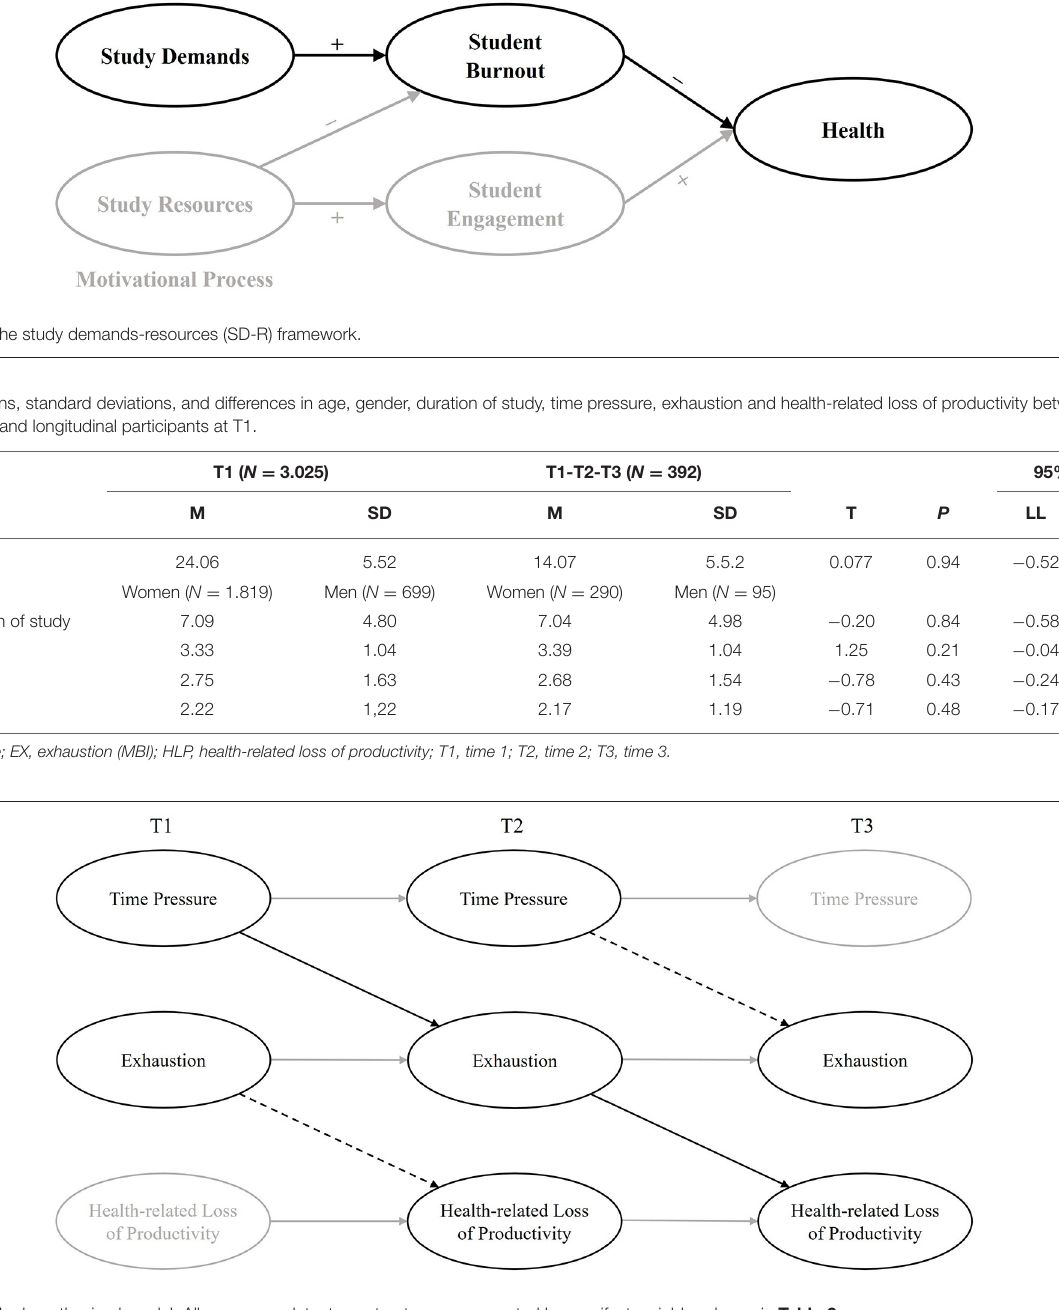
three measurement points (36). The model fitted the data significantly better than the unrestricted model. The standardized loadings of the measurement-time-specific indicators were < 0.40 and can be classified as low to moderate. We can therefore assume over